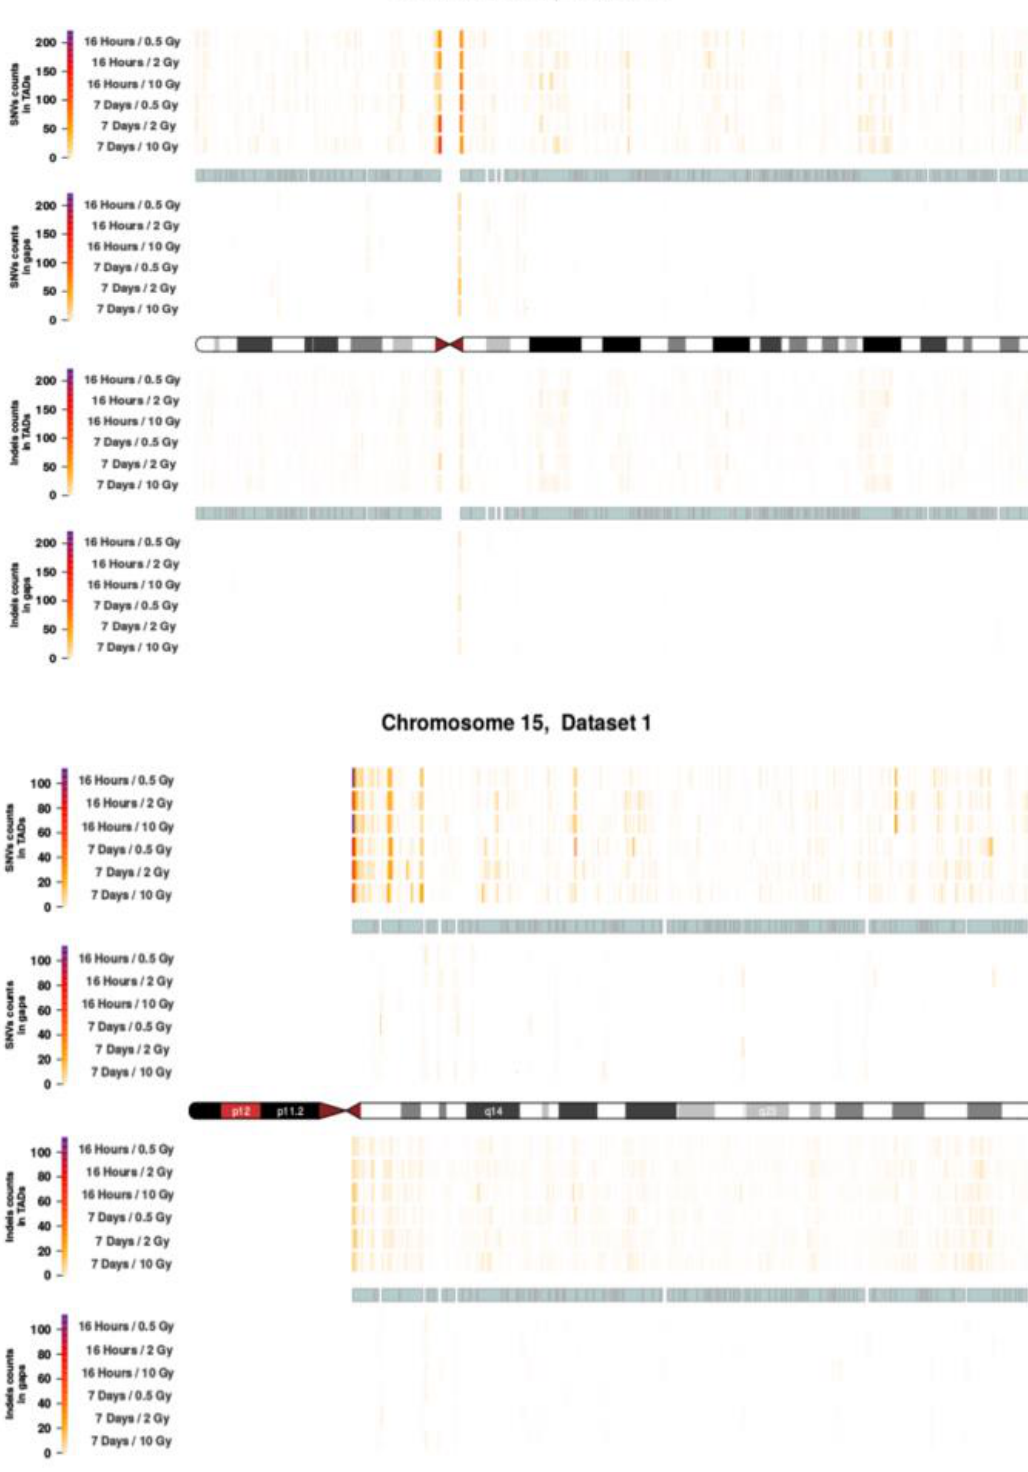
each portion. The heatmaps with color gradients from white through orange and red to dark purple represent values ranging from 0 to 104 of variant counts.